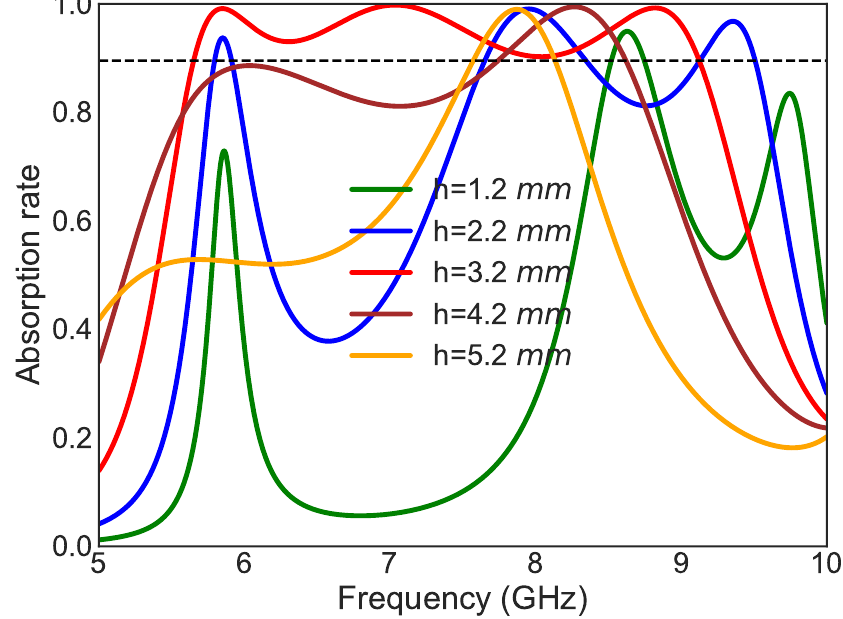
Figure 8. Absorption rate for different values of thickness (h), An illumination of linearly polarized TE wave is